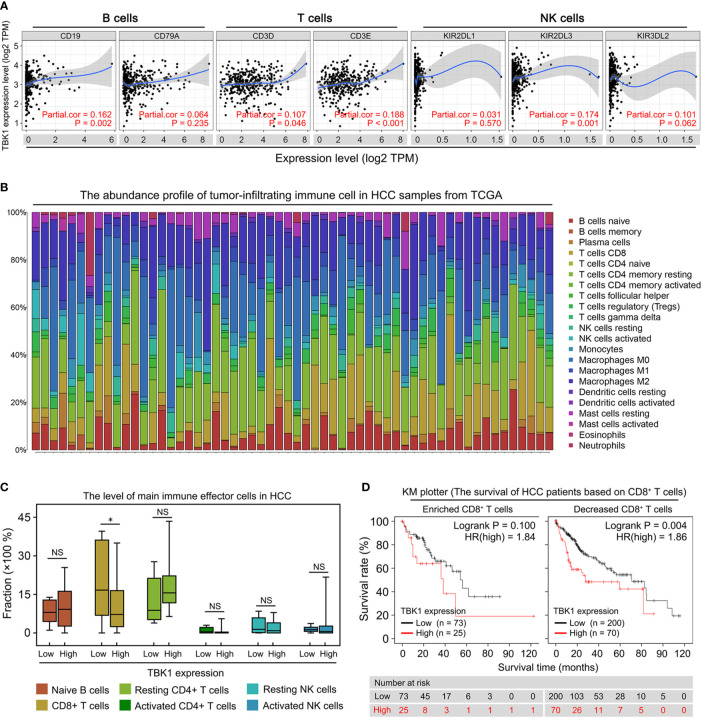
Correlation of TANK-binding kinase 1 (TBK1) expression with tumor immune infiltration in patients with hepatocellular carcinoma (HCC). (A) Tumor Immune Estimation Resource (TIMER) was used to analyze the correlation of TBK1 expression with the markers of immune effector cells [B, T, and natural killer (NK) cells]. (B) 22 tumor-infiltrating immune cells in HCC samples were estimated using the CIBERSORT algorithm. (C) The proportion of main immune effector cells in HCC tissues with high and low TBK1 expression. (D) Kaplan–Meier overall survival (OS) curve of high and low TBK1 expression in HCC based on the number of tumor-infiltrating CD8+ T cells. NS, not significant; *P < 0.05.